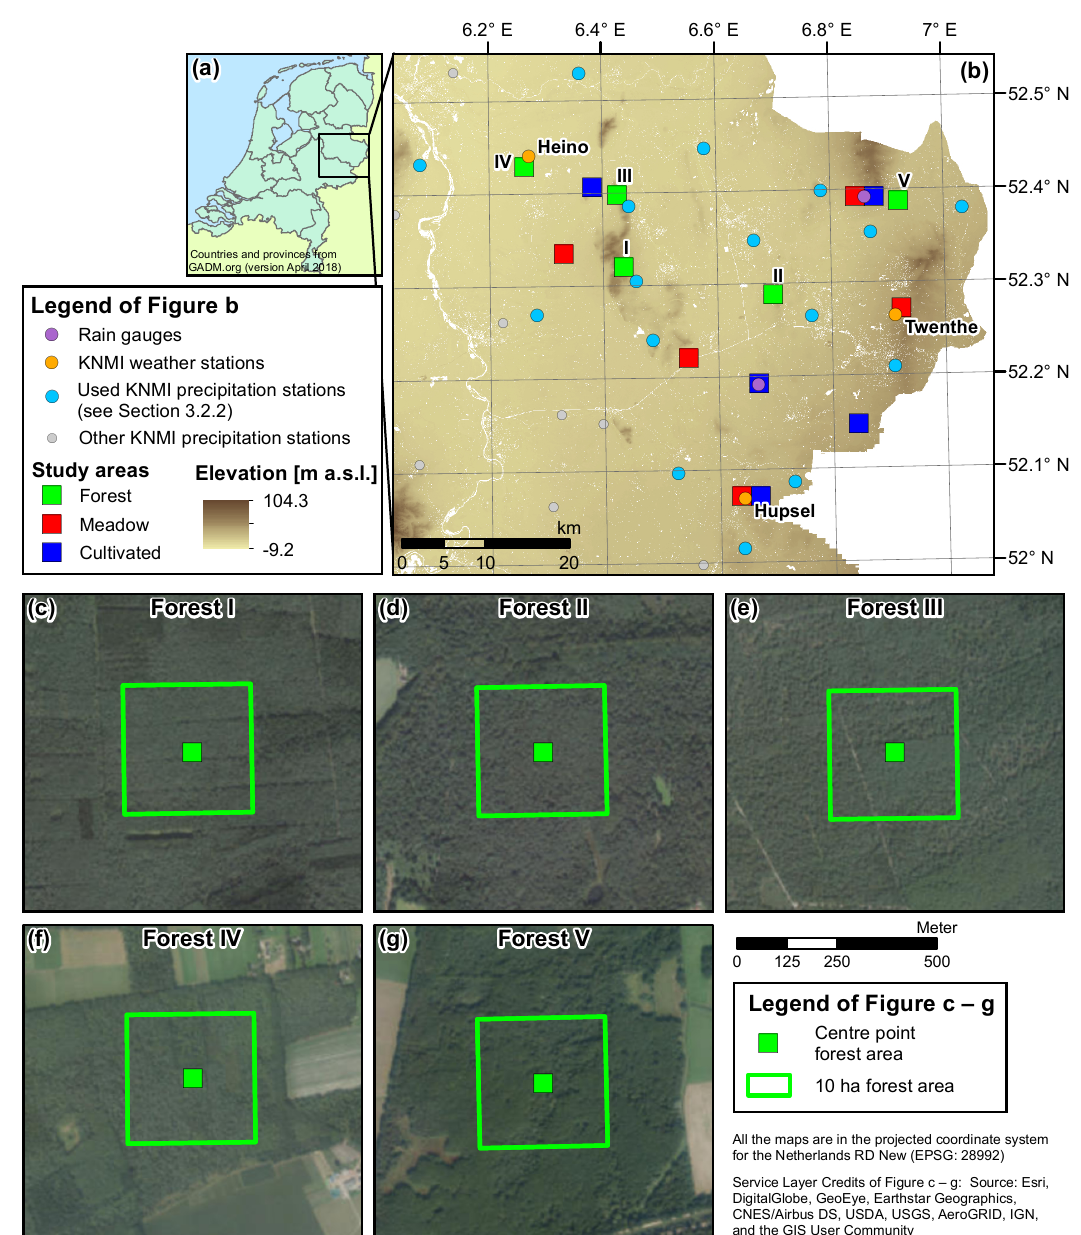
Figure 1. ( a ) Location of the Twente region in the Netherlands. ( b ) The Twente region with the selected study fields and the meteorological measurement locations. Background is the digital elevation model AHN2 [45]. The grid shows WGS84 coordinates. ( c – g ) Zoom-ins of the selected forest areas I to